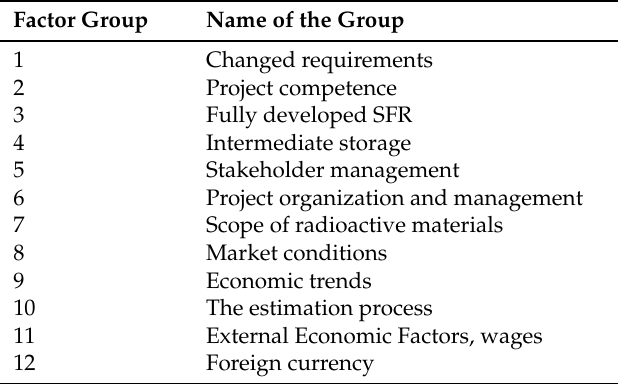
Table 1. Uncertainty factor groups established.